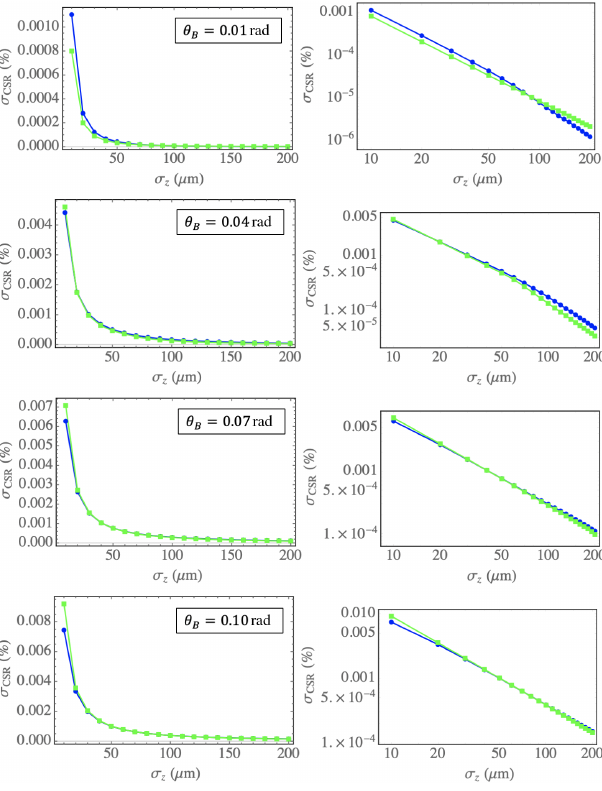
FIG. 4. The CSR rms energy spread versus initial bunch lengths of an electron beam traversing a bend ( L B ¼ 0 . 55 m) for various bend angles. Left column: The CSR rms energy spread from ELEGANT (blue) and Eq. (13) (green). Right: Log-Log plot of the CSR rms